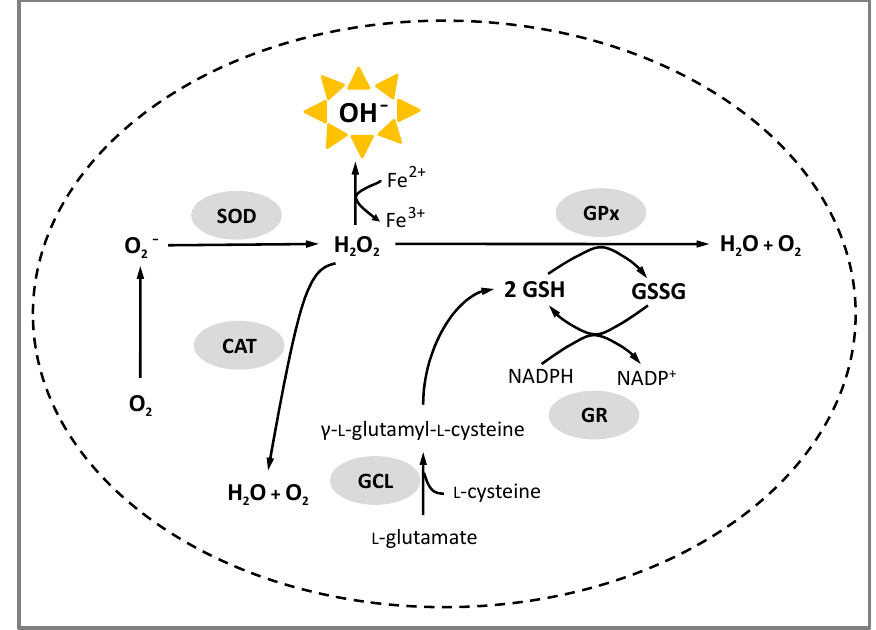
Figure 1. Cellular enzymes and mechanisms involved in protection from reactive oxygen species (ROS). SOD: Superoxide dismutase; CAT: Catalase; GPx: Glutathione peroxidase; GCL: Glutamate-cysteine ligase; GR: Glutathione reductase; GSH: Glutathione; GSSH: Oxidized glutathione; NADP + /NADPH: Nicotinamide adenine dinucleotide phosphate (oxidased/reduced).